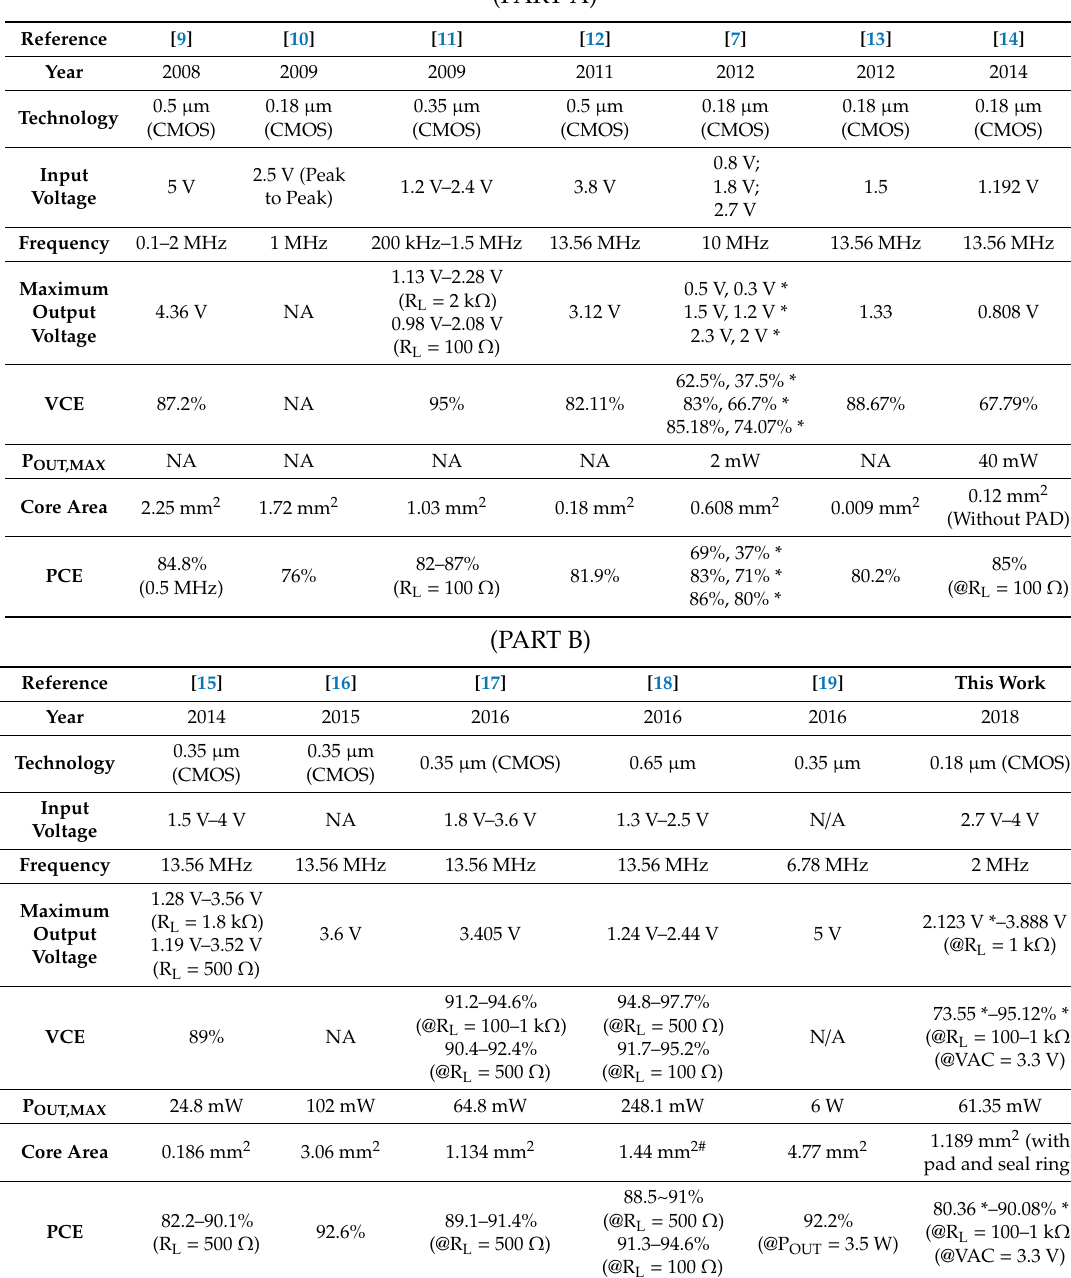
Table 3. Circuit performance